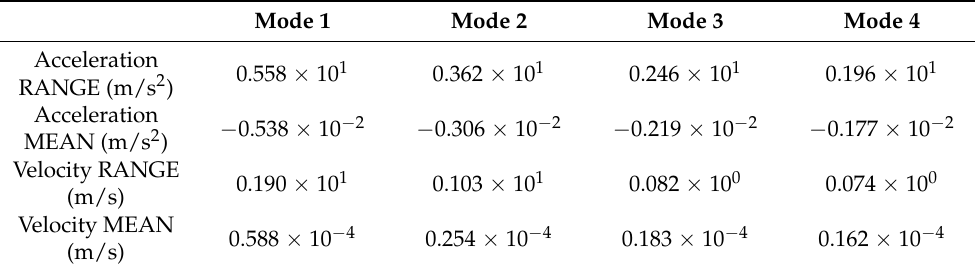
The tower x-direction load. The tower x-direction load can be reflected by the change curves of the x-direction torque and force of the tower bottom. Therefore, the timing sequence load is shown in Figures 18 and